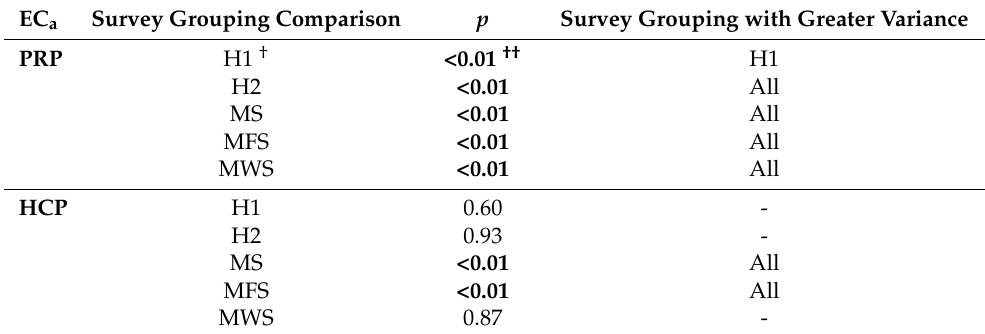
Table 6. Summary of the homogeneity of variance between all 12 monthly perpendicular (PRP) and horizontal coplanar geometry (HCP) apparent electrical conductivity (EC a ) surveys and five reduced survey groupings (i.e., H1, H2, MS, MFS, and MWS). Additional details of the survey groupings are presented in Table 2. Homogeneity of variance was evaluated using the Levene’s